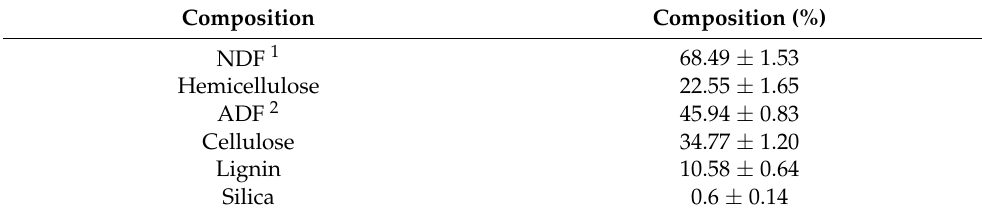
Table 1. Composition of lignocellulosic content of OPEFB.